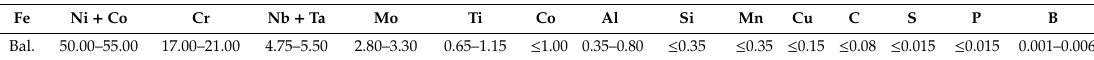
Table 2. Chemical composition (% mass) of INCONEL 718 alloy powder provided by Carpenter Technology Corporation.